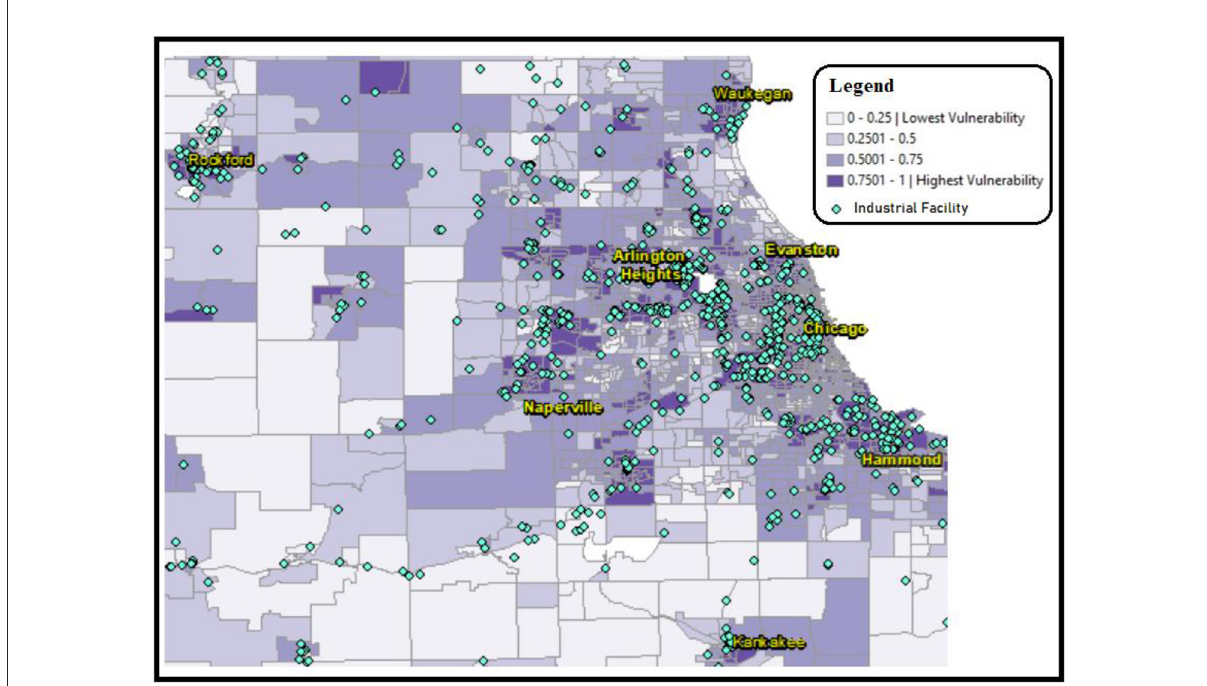
FIGURE1 CDC census tract Social Vulnerability Index (SVI) represented in shades of purple, overlaid with industrial facility sites represented with turquois diamonds. This map shows a prevalence of industrial facilities located in areas of high SVI scores. Industrial site source data retrieved from Commission for Environmental Cooperation (CEC) (10), SVI data retrieved from CDC data (2018), analysis performed using ESRI ArcMap 10.8.